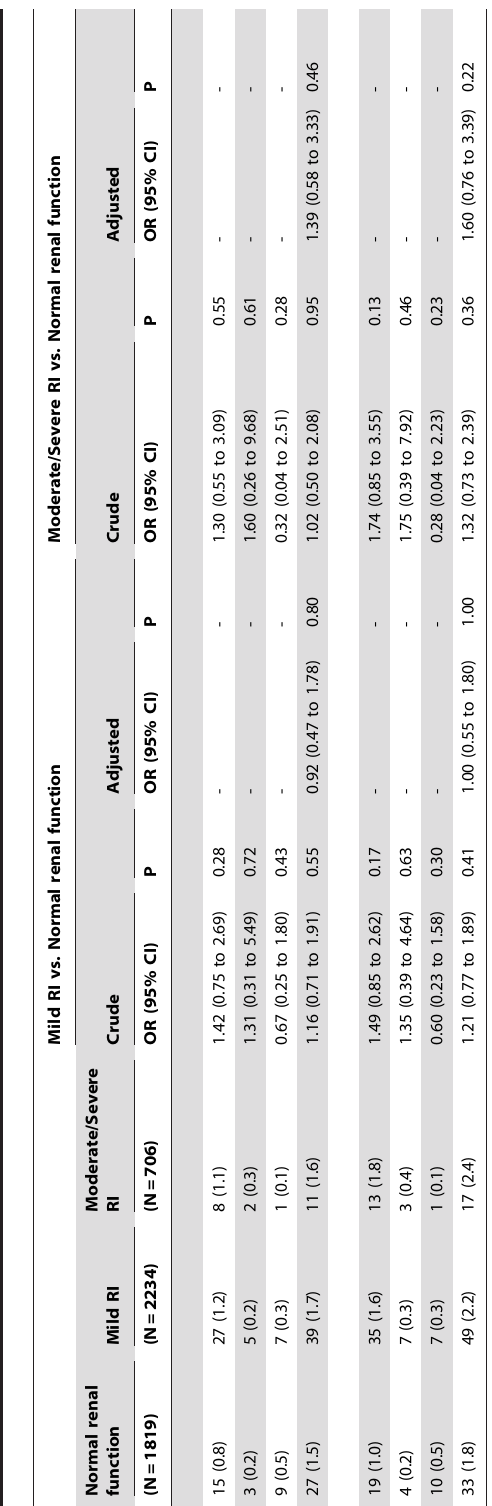
Table 5 . No differences were observed between patients with moderate/severe RI and patients with mild RI compared with patients with normal renal function in terms of in-stent late loss (normal renal function = 0.19 6 0.65 mm, mild RI= 0.19 6 0.69 mm, moderate/severe RI= 0.18 6 0.53 mm) and in-segment binary restenosis (normal renal function = 7.9%, mild RI= 8.1%, moderate/severe RI =11.2%). Figure 2 depicts the cumulative frequency of in-stent late lumen loss for lesions among patients with moderate/severe and mild RI and normal renal